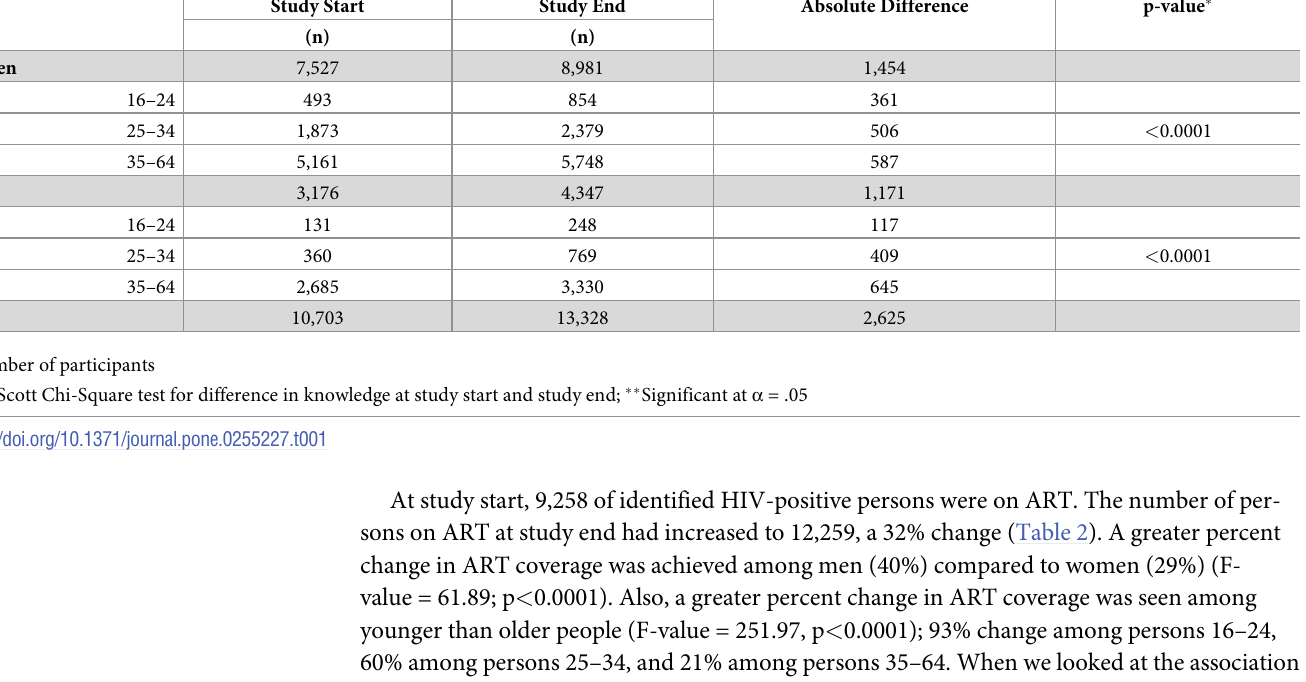
Table 1. Increases in knowledge of HIV-positive status from study start to study end in the intervention communities by sex and age. Study Start